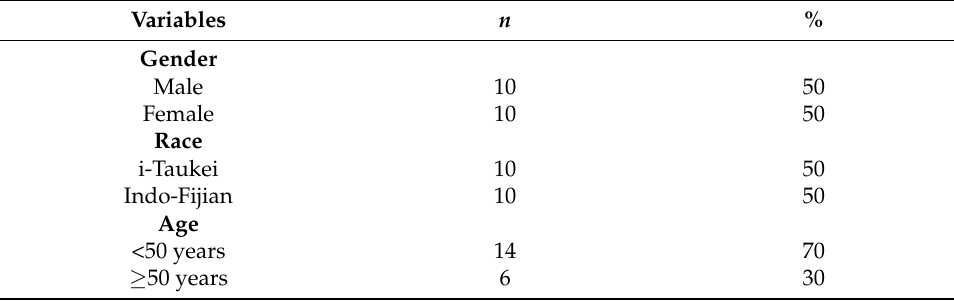
Table 4. Characteristics of the participants ( n =